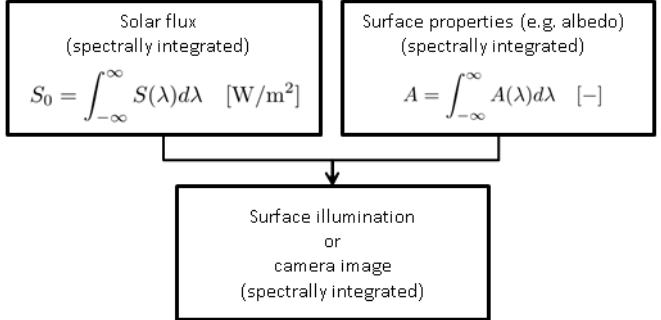
Figure 3. Generation of spectrally integrated images. All relevant parameters such as solar flux or optical properties of the surface are averaged and then used in the